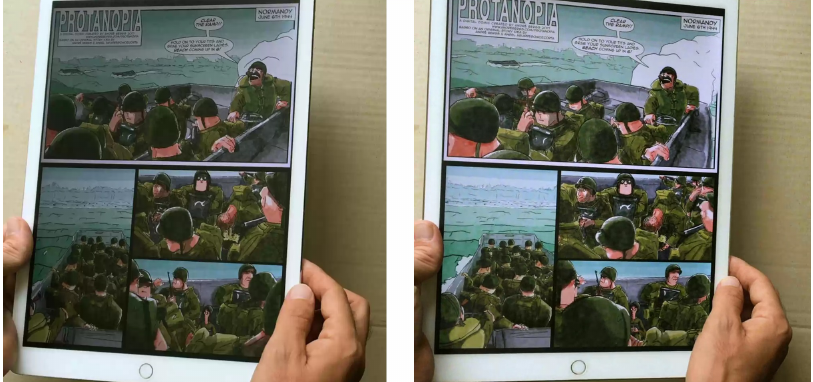
Figure 4. The digital comic book “Protanopia” created by Andre Bergs. The reader can control the camera angle by tilting the screen. The panel are animated with continuous loops. Image extracted from the author’s website